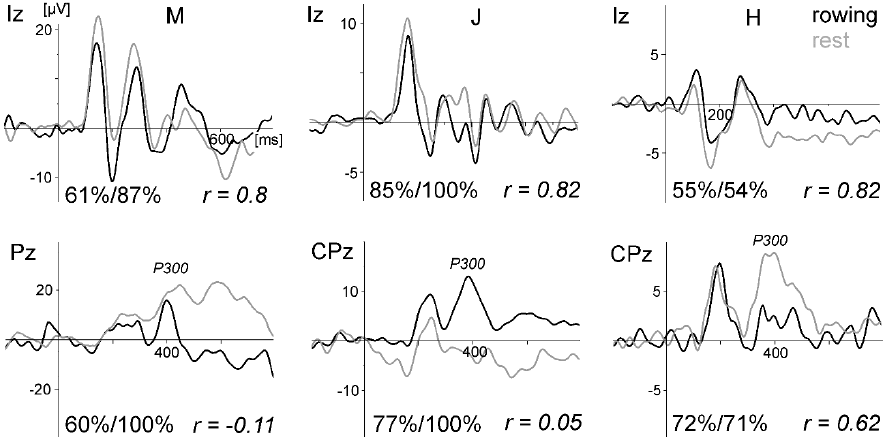
Figure 2. Event-related potential (ERPs) of the visual oddball task comparing rowing and rest for all three subjects (M, J, and H) of pilot Study 1. Upper graphs: visual evoked potentials (VEPs) evoked by the frequent checkerboard stimulus at electrode site Iz (referenced to Cz to obtain a larger and cleaner signal because VEP activity and electromyogram (EMG) artefacts are lower at Cz compared to the mastoids). Below: the P300 waveform at Pz/CPz (linked mastoid reference for M and H, and right mastoid for J due to the lost left mastoid channel). The vertical line marks the stimulus onset. The numbers at the bottom of each graph present the percentage of artefact-free trials included in the averages for rowing and rest of the chosen electrode site and the correlation coefficients (Pearson) of the two waveforms. The high dropout rate for subject H was mainly due to eye-blink artefacts. For subject M, three channels (FCz, CPz, and CP4) were lost completely due to artefacts during rowing: for subject J, the left mastoid channel was lost. Furthermore, a P300 is missing during rest for J, because he did not count the target because of an imprecisely given instruction. For M and H, the P300 was larger during rest. The ERPs of the deviant stimulus condition are not displayed, because they showed results similar to those of the frequent condition.